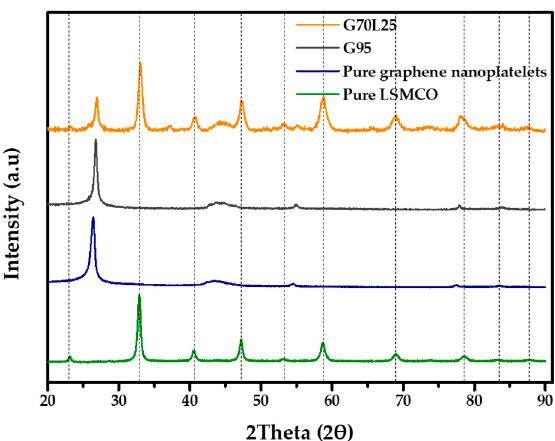
Figure 2. XRD pattern of comparing G70L25, G95, pure graphene nanoplatelets, and pure LSMCO; The DIFFRAC.EVA program was used to identify the data.